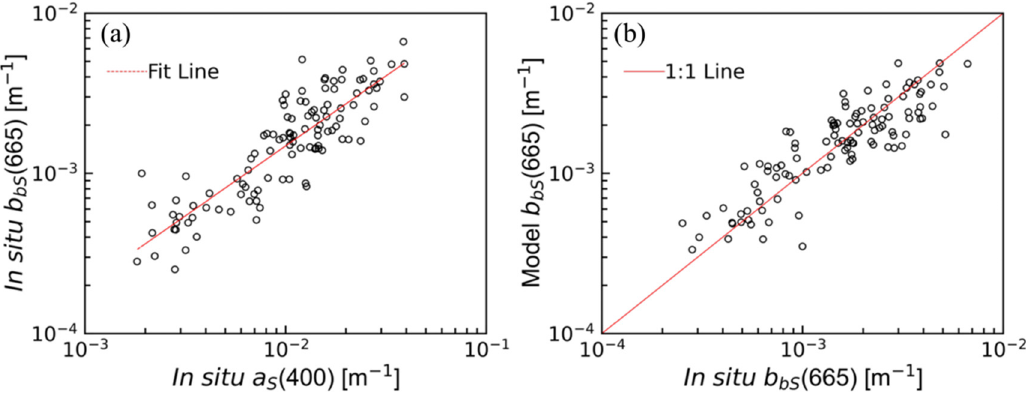
Figure 3. The relationship between the in situ back-scattering coefficient of non-algal suspended particles at 665 nm ( b bS ( 665 ) ) and the in situ absorption coefficients of non-algal suspended particles ( a S ( 400 ) ) obtained using the samples from the NOMAD dataset ( N = 91) ( a ) and the comparison between the in situ and modelled b bS ( 665 ) ( b ). Table 2. Table showing the different satellite-retrieval algorithms and their coefficients used in the present work to estimate chlorophyll-a ( 𝐵 ) and total suspended matter ( 𝑆 ) concentrations. Algorithms Equations Variables